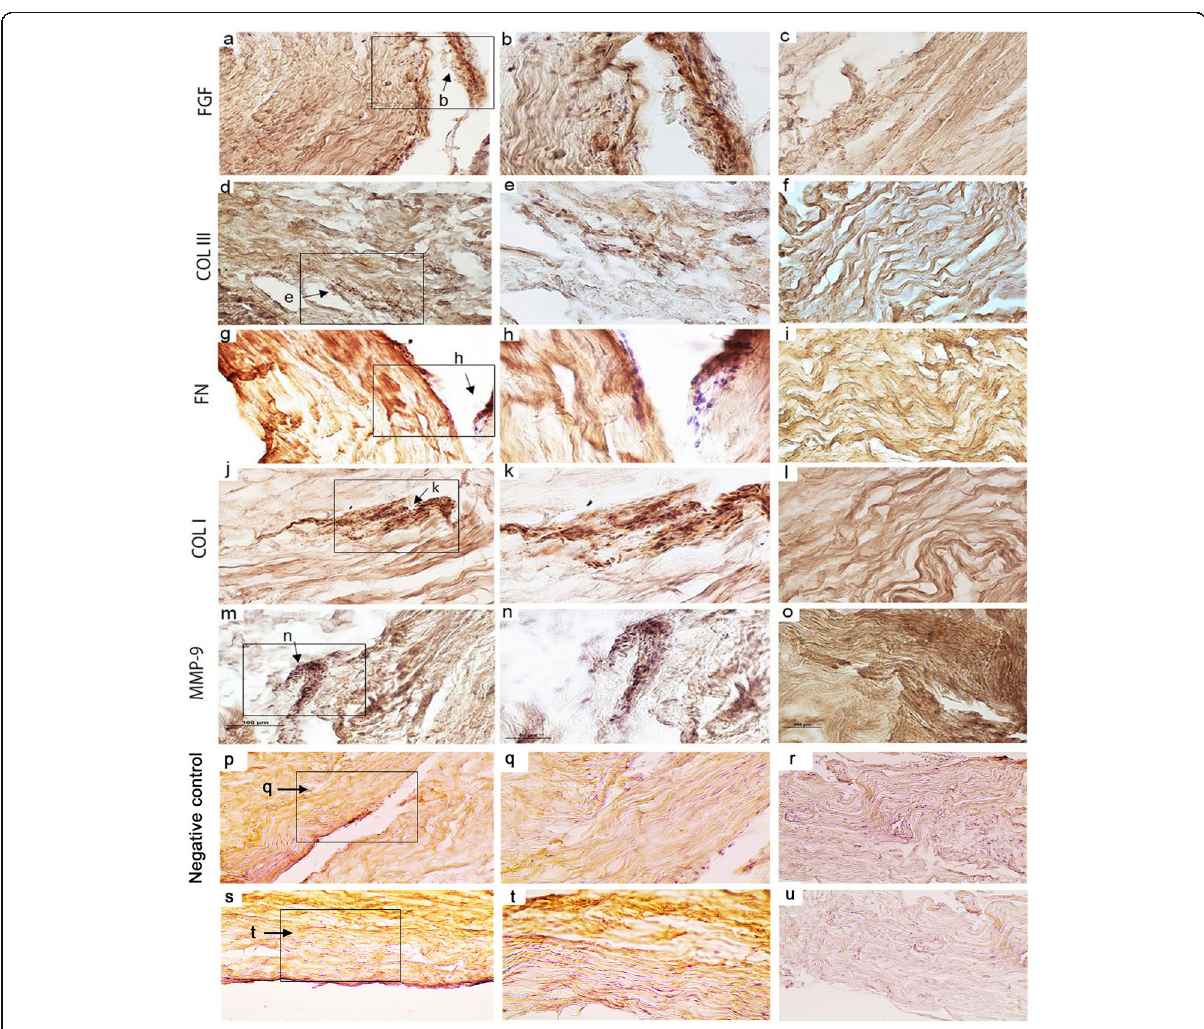
Fig. 7 Protein expression of FGF ( a-c ), COL III ( d-f ), FN ( g-i ), COL I ( j-l ), MMP-9 ( m-o ), negative control for horse anti mouse ( p-r ), and goat anti rabbit ( s-u ) secondary antibodies in Achilles tendon tissue biopsies. Light microscope images are representative of 5 patients. The first and third columns displays 20x magnification, while the second column depict 40x magnification from the black rectangles in the first column. The first